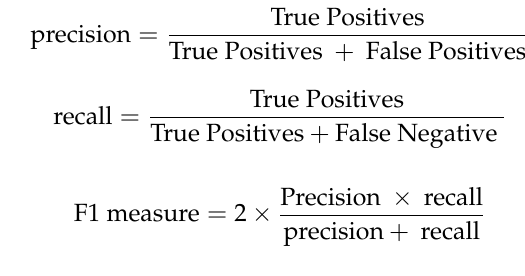
Table 3. The results were obtained by classification model on the benchmark test set ( Mtest ). Dataset